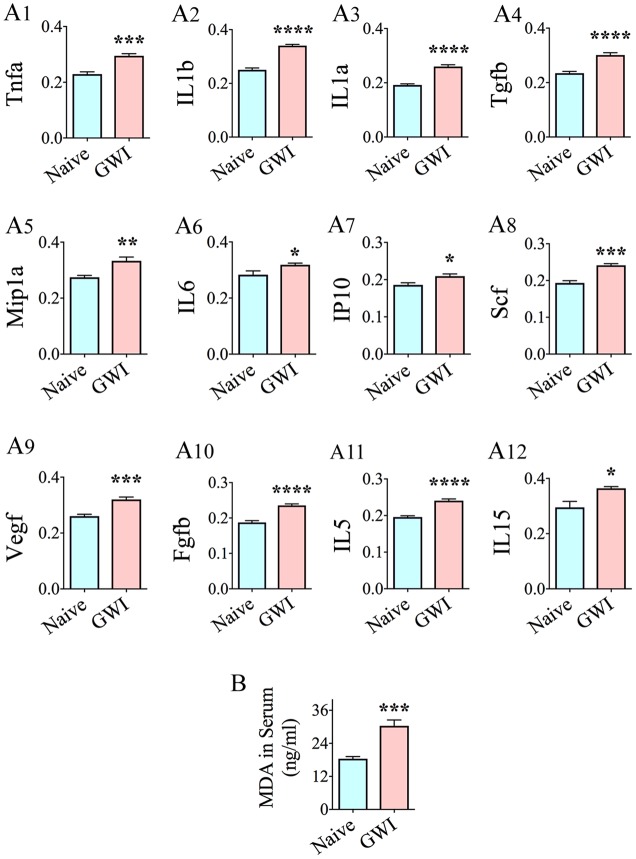
Animals with chronic gulf war illness-like symptoms (GWI-rats) showed increased levels of multiple pro-inflammatory cytokines and chemokines, and malondialdehyde (MDA) in serum when examined 6 months after exposure to GWI-related chemicals and stress. Bar charts A1–A12 compare the relative levels of cytokines and chemokines between naïve control rats and GWI-rats (n = 6/group). Note the increased levels of Tnfa, IL1b, IL1a, Tgfb, MIP1a, IL6, IP10, Scf, Vegf, Fgfb, IL5, and IL15 (A1–A12) in GWI-rats, in comparison to age-matched naive control rats. Bar chart B illustrates an elevated concentration of MDA in the serum of GWI-rats, in comparison to naïve control rats (n = 6/group). ∗, p < 0.05; ∗∗p < 0.01; ∗∗∗p < 0.001; ∗∗∗∗p < 0.0001.